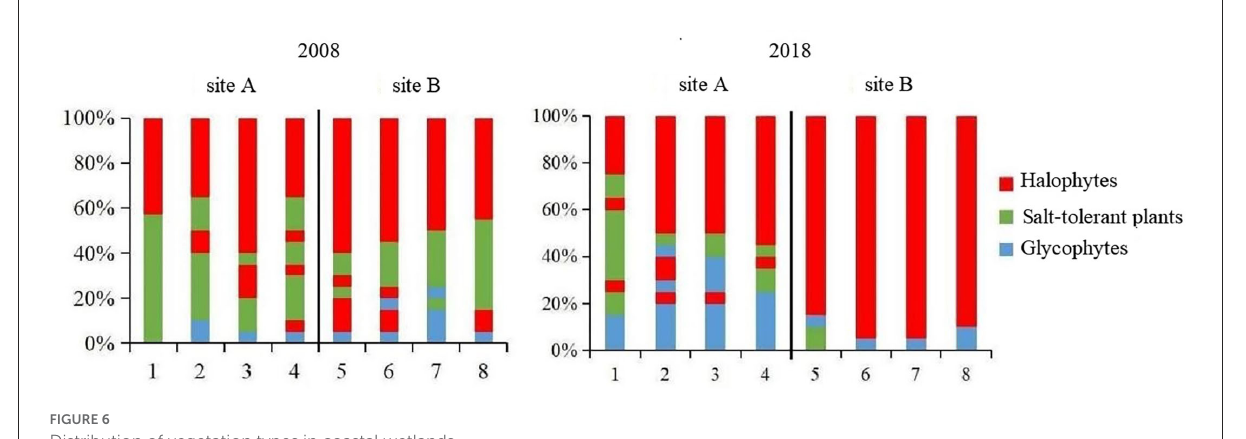
FIGURE6 Distribution of vegetation types in coastal wetlands.